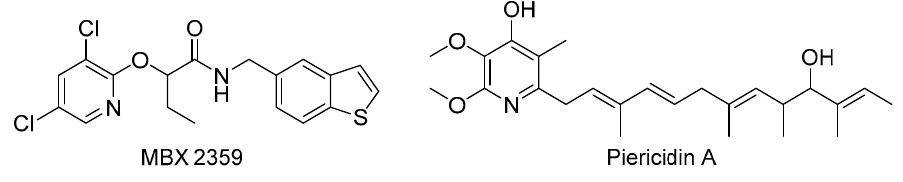
Figure 4. Structures of MBX 2359 and piericidin A.